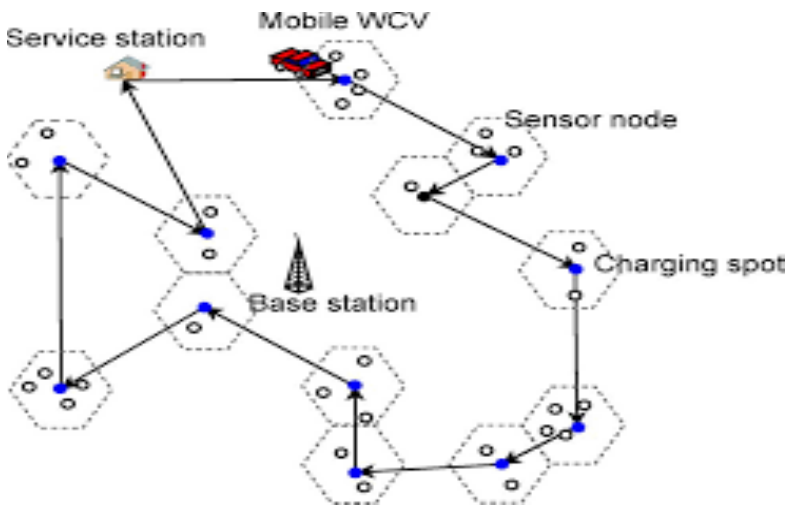
Figure 3. A model of wireless charging vehicle which periodically visits a WSN to recharge the